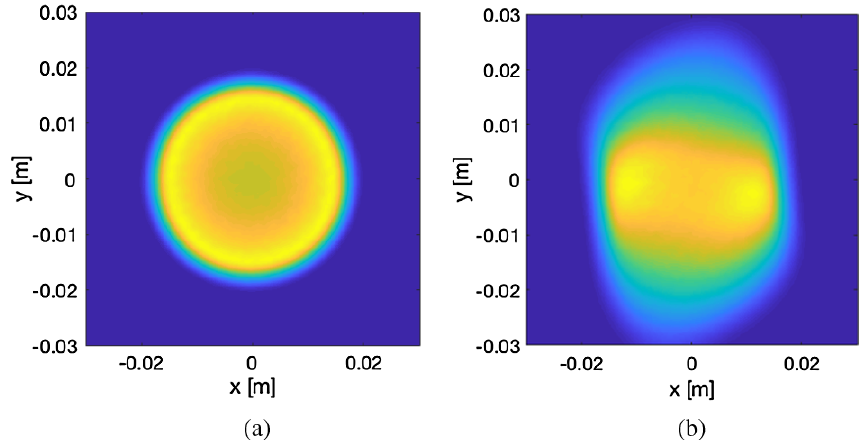
FIG. 7. (a) Transverse view of bunch without deflection, (b) transverse view of a deflected bunch at